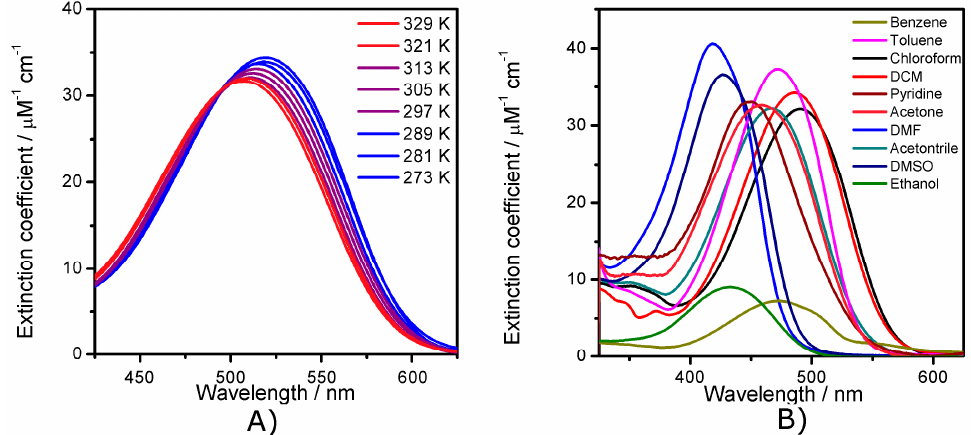
Figure 5. Experimentally measured ( A ) variable temperature absorbance of 1A in CHCl 3 and ( B ) electronic absorbance of 1A in a range of solvents.